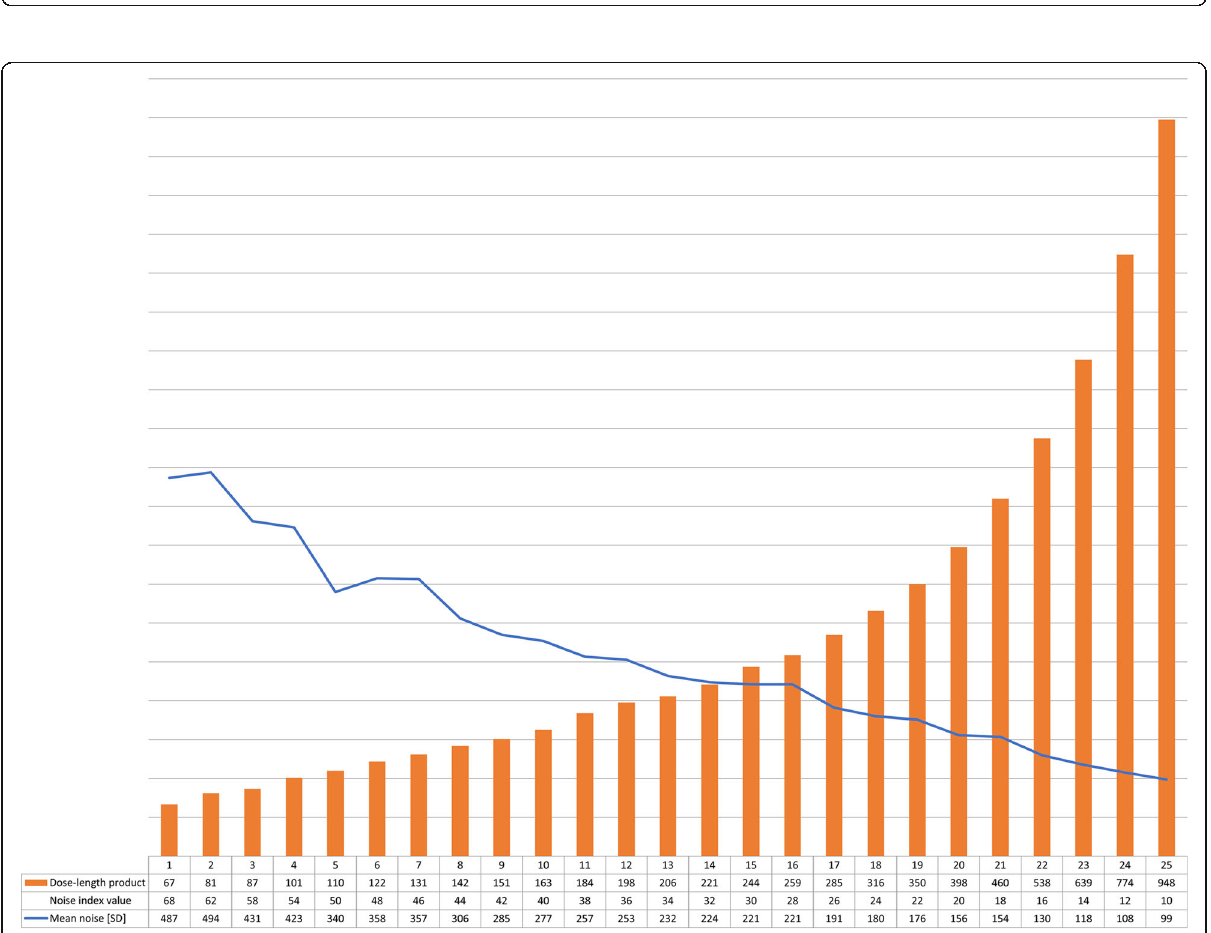
Fig. 2 Experiment roadmap. CT, Computed tomography; SD, Standard deviation; GGO, Ground-glass opacity; CTDI, CT dose index